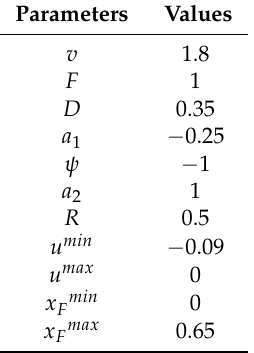
Table 1. Parameter values used in numerical simulation.